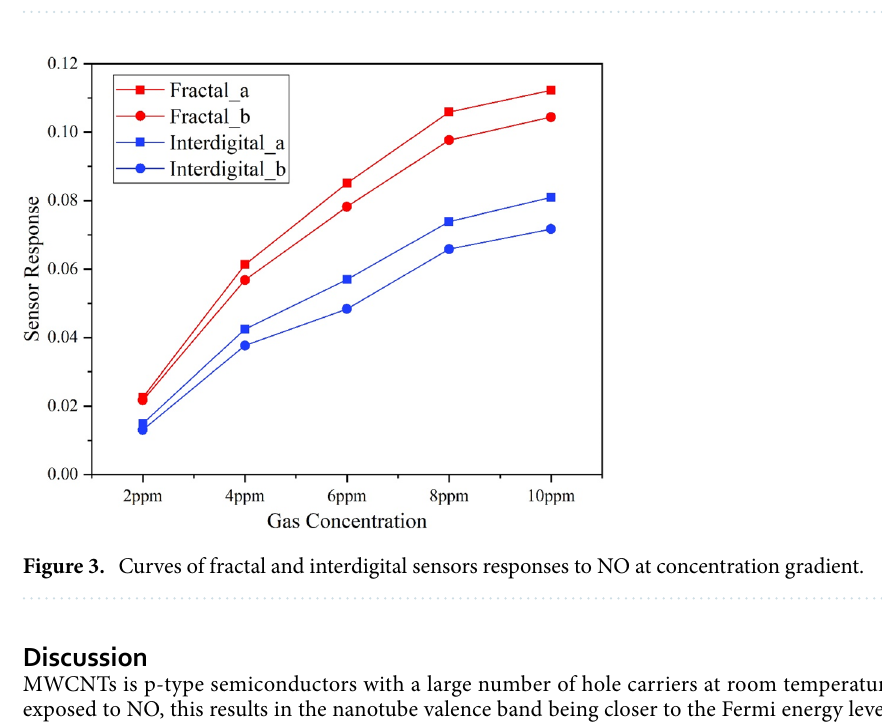
Figure 2. Conductance of MWCNTs to 100 ppm NO.